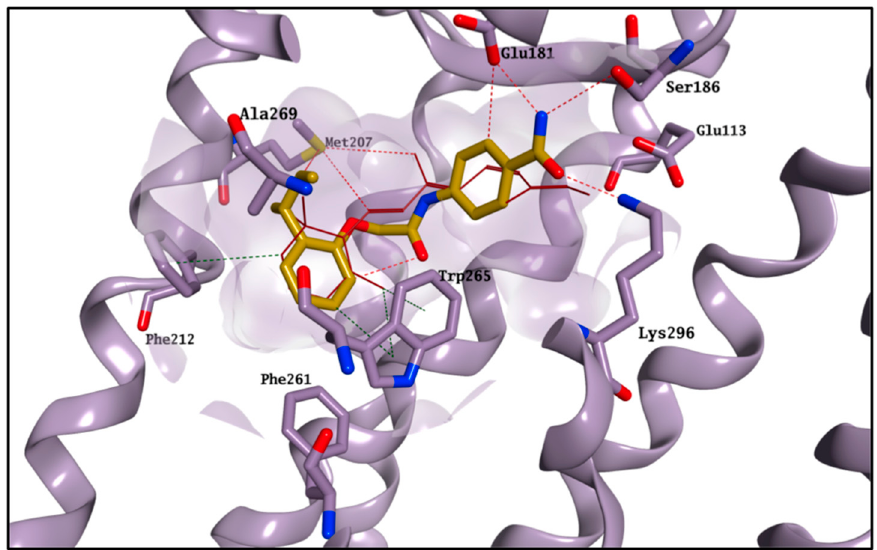
Figure 4. Best binding pose found for compound 5 (carbon atoms in gold). The binding site area is represented as molecular surface. Rhodopsin is represented as lilac ribbon. Ribbon for residues 261–271 and 289–295 is hidden for clarity. Cocrystallised 11- cis -retinal is shown in garnet.